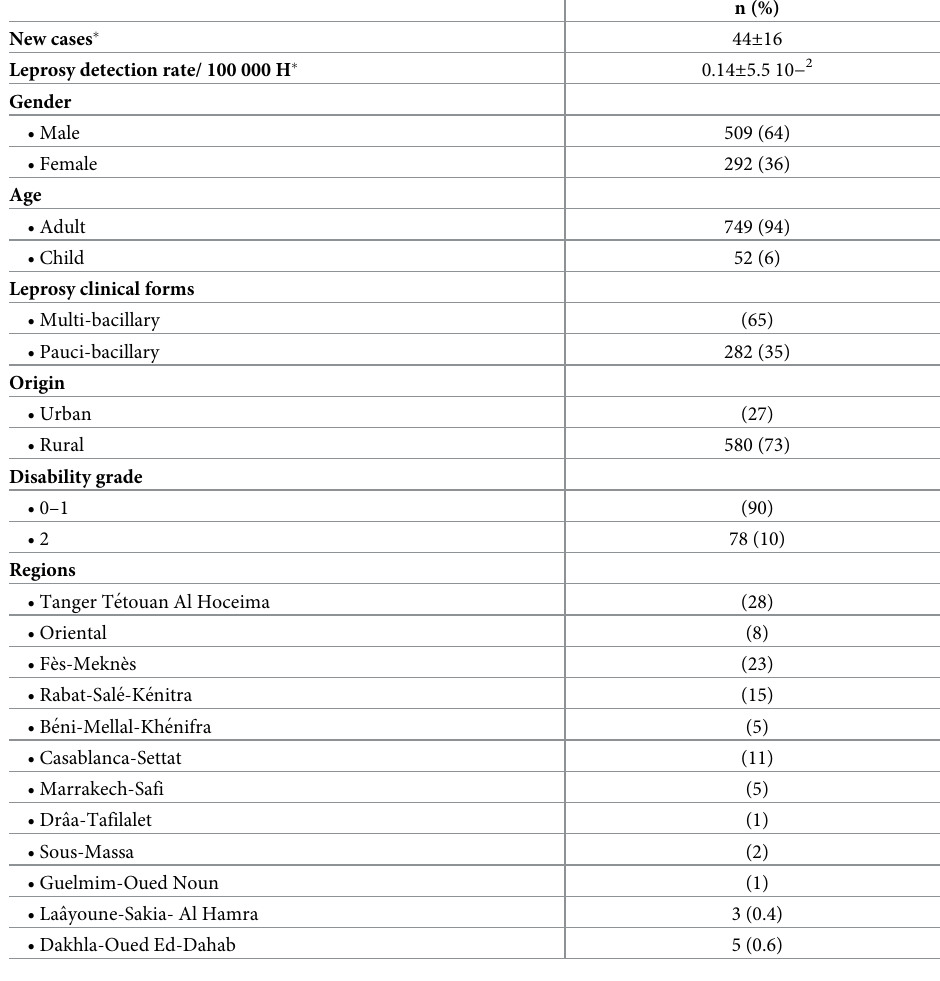
Table 1. Epidemiological characteristics of leprosy in Morocco during the period